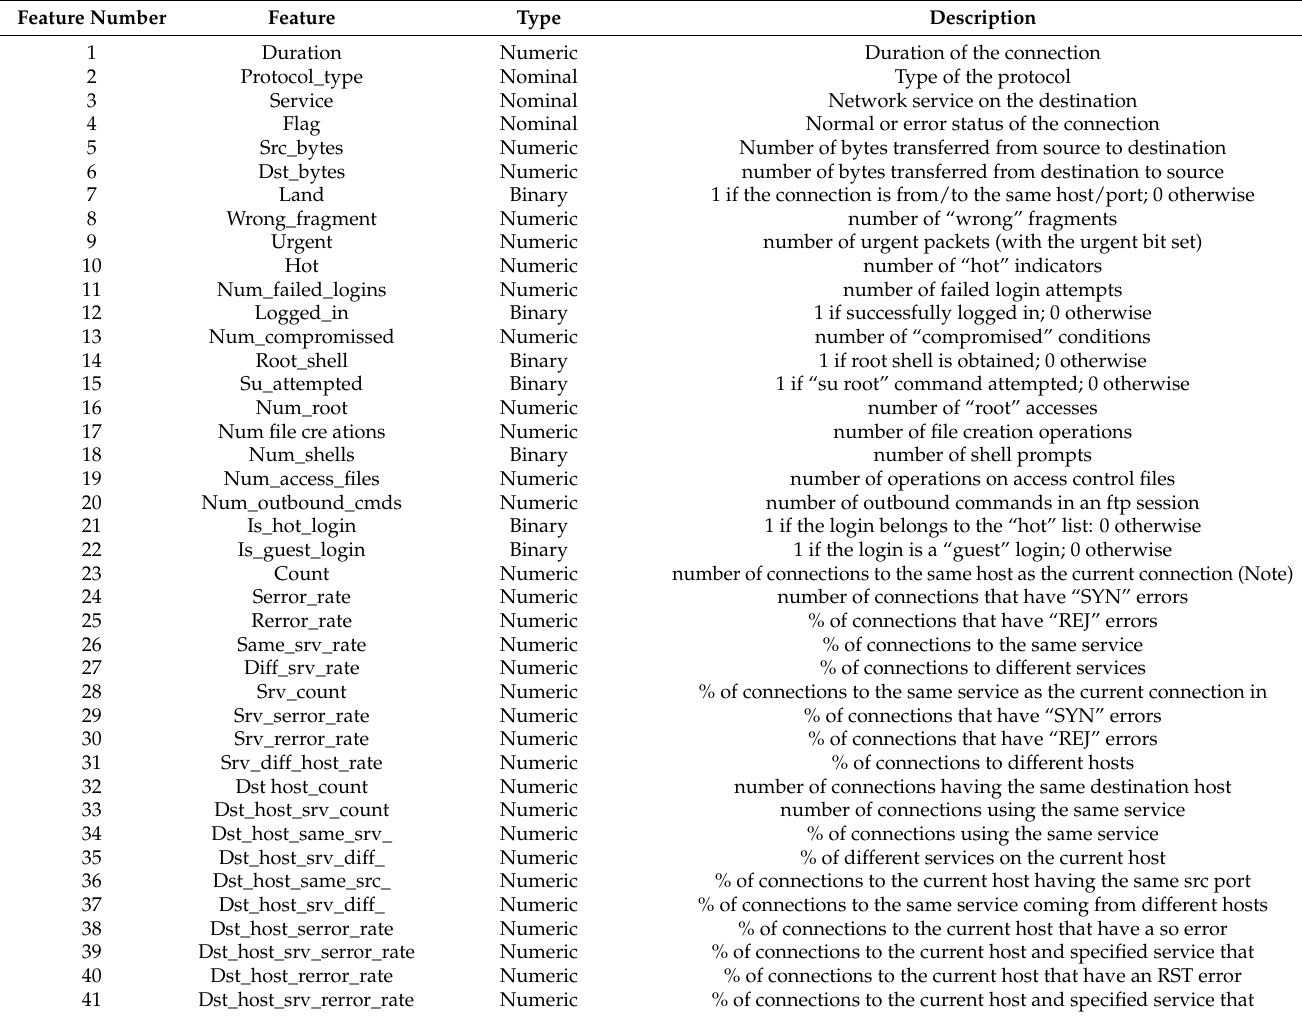
Table 1. Total features in the NSL-KDD dataset. Data from